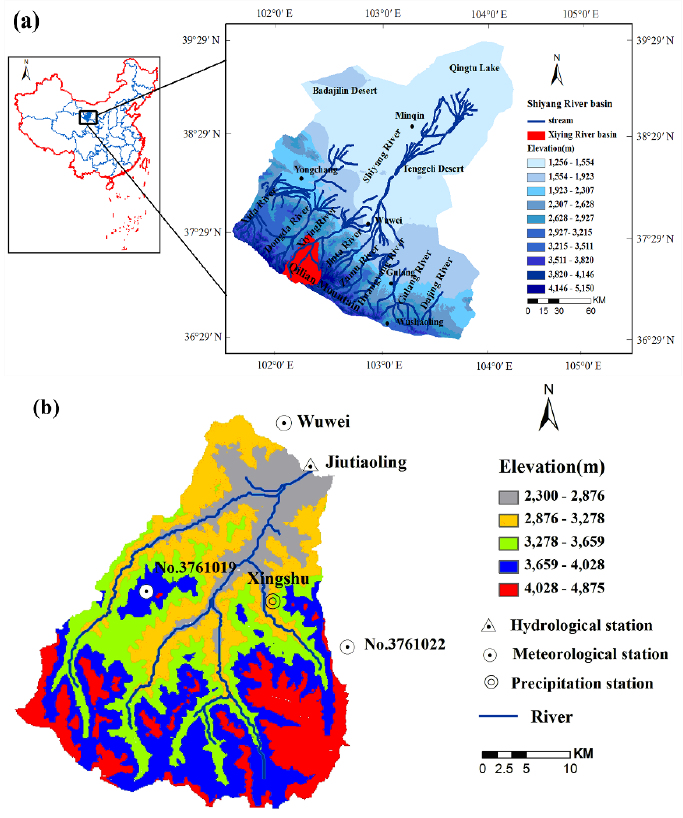
Figure 1. Basic information of the Xiying River basin. ( a ) Geographic location of Xiying River in northwestern China; ( b ) Meteorological and hydrological conditions in the Xiying River